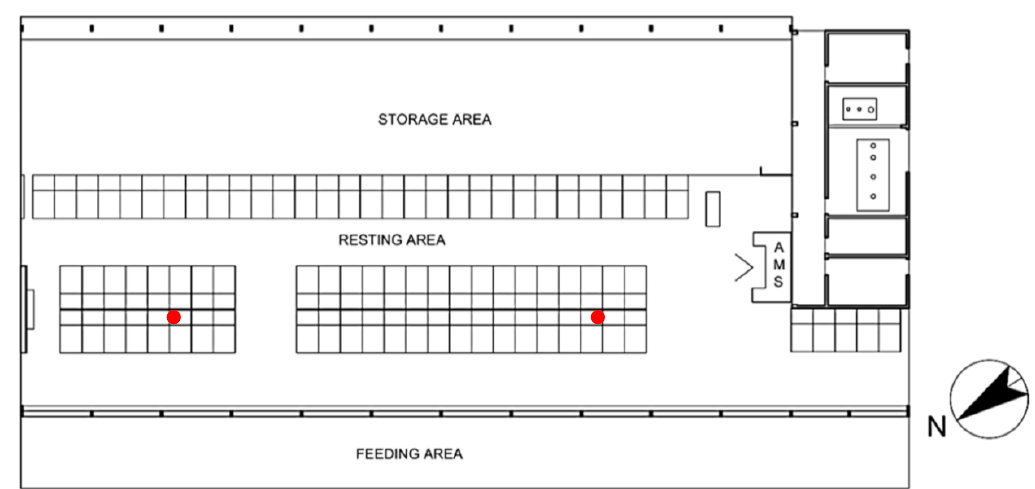
Figure 1. Layout of the case study barn (AMS: Automatic Milking System; • position of the two thermo-hygrometer data loggers).